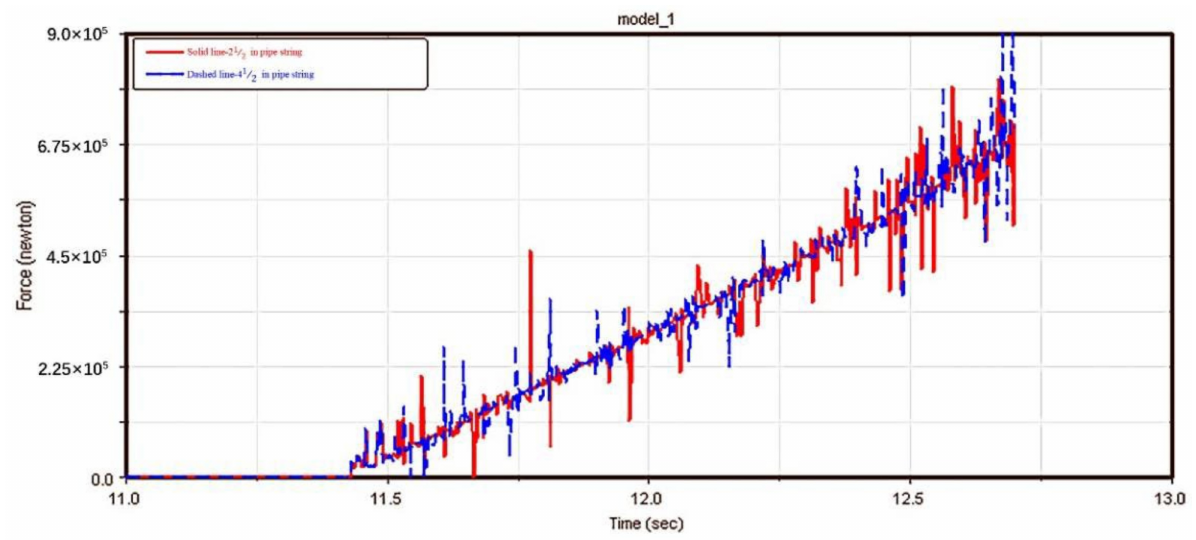
Figure 20. Contact collision force curve between arm and